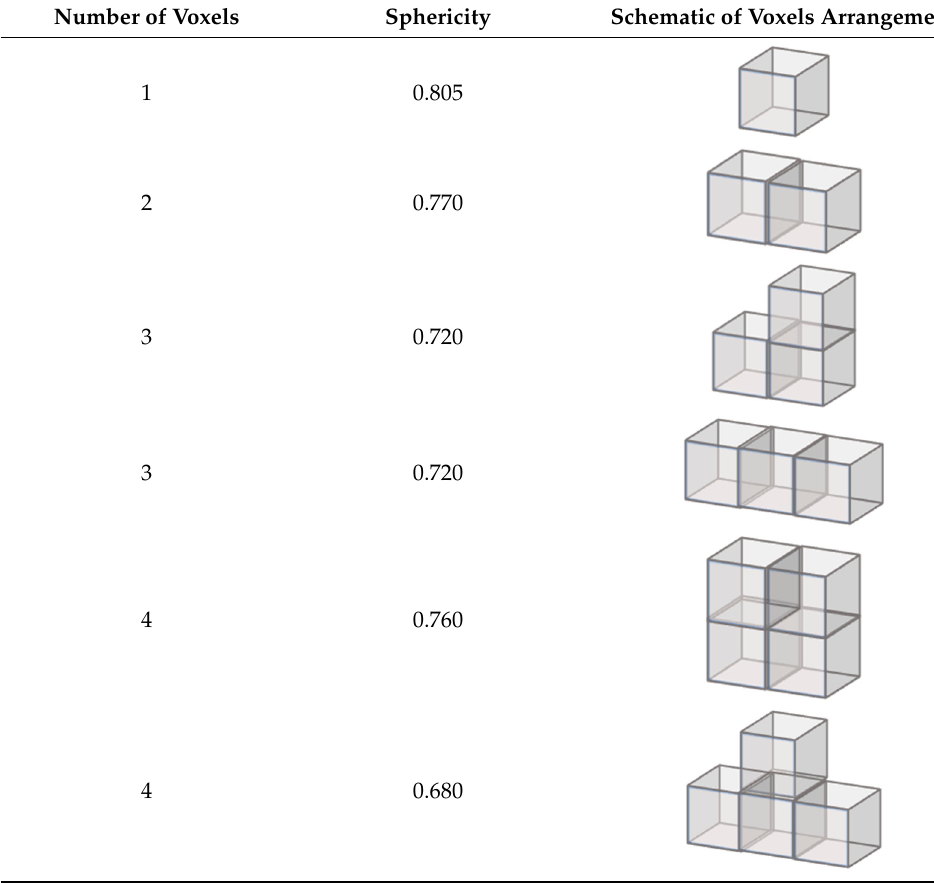
Table 5. Sphericity and number of voxels of several detected voids within the microstructure of a single freely strand.